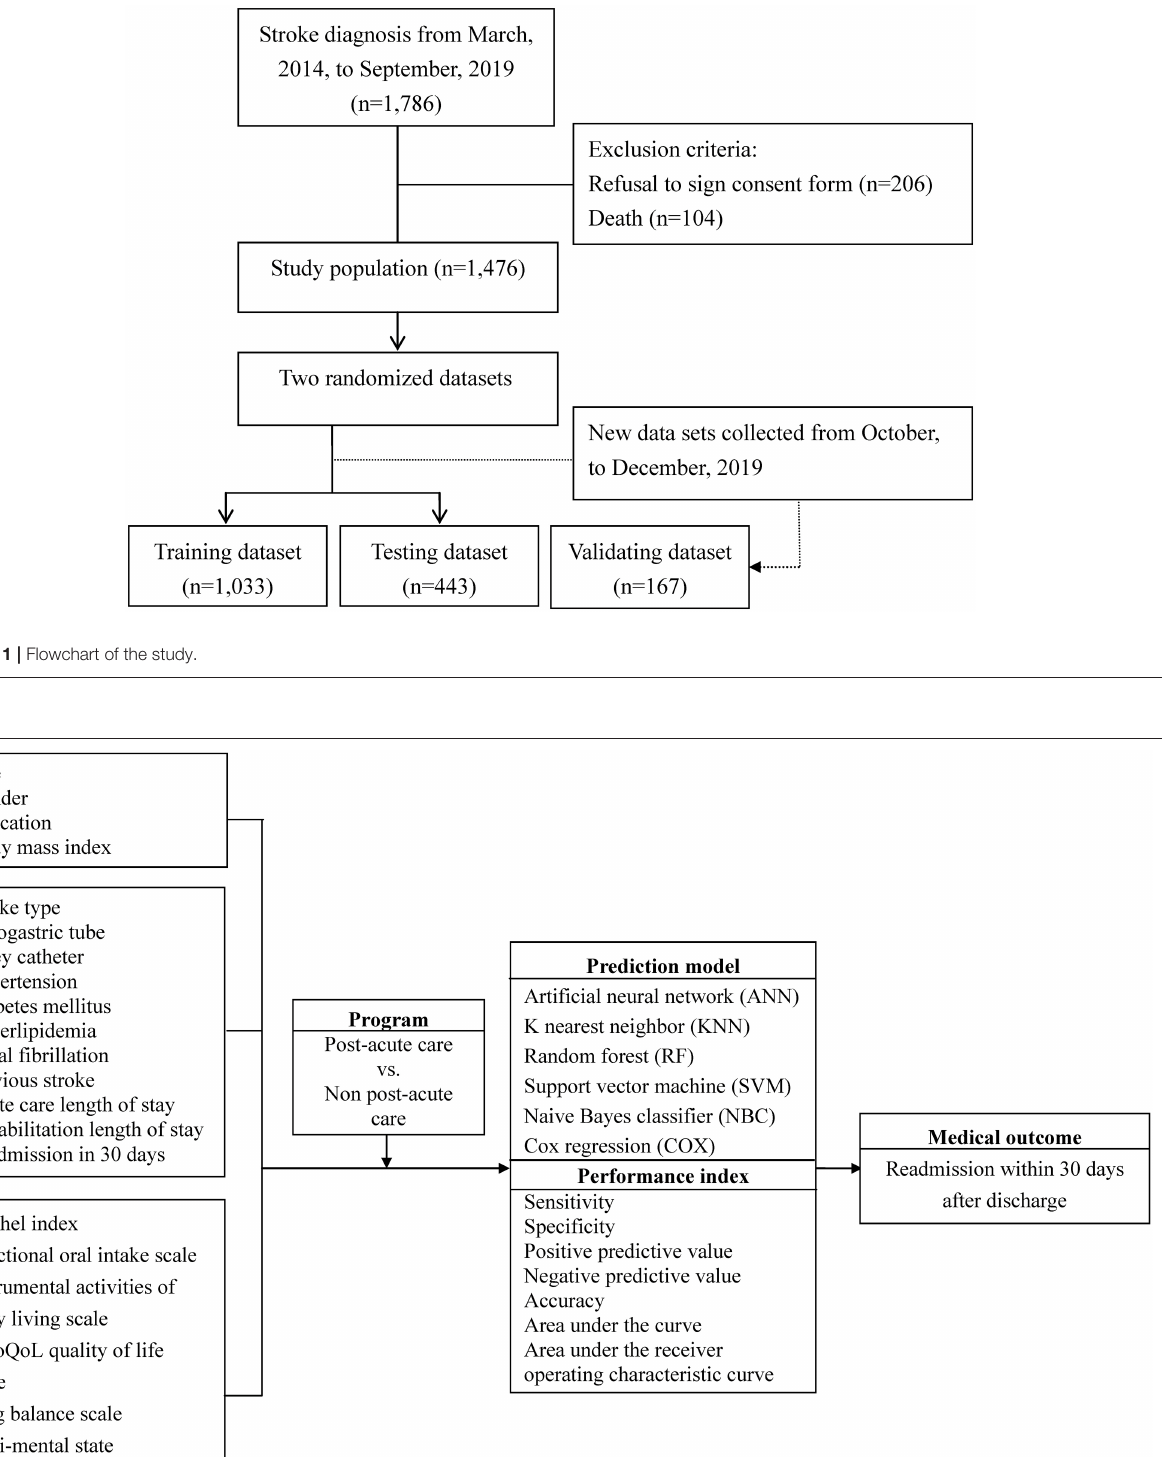
Frontiers in Neurology |